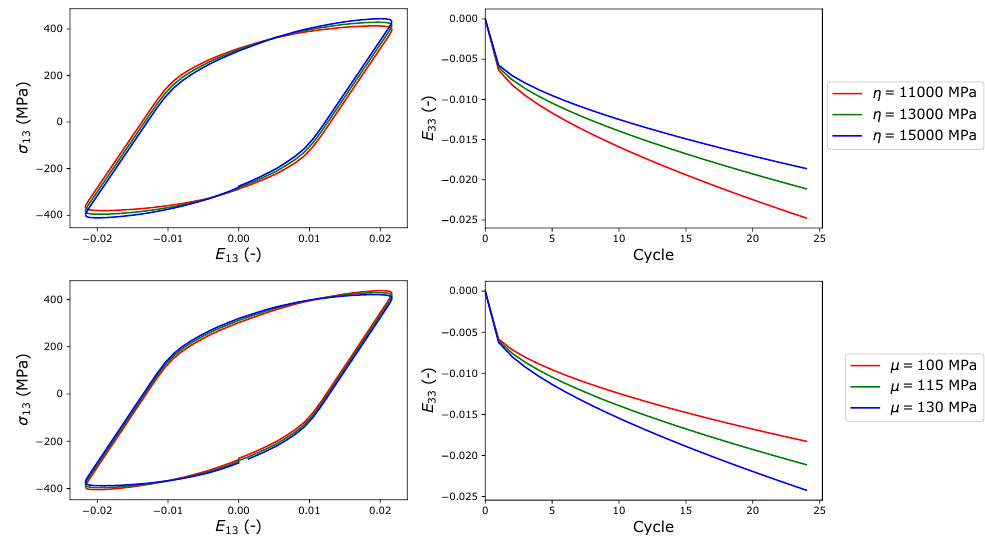
Figure A1. Effect of CP kinematic hardening parameters η and µ on the stress–strain hysteresis loop and the axial creep